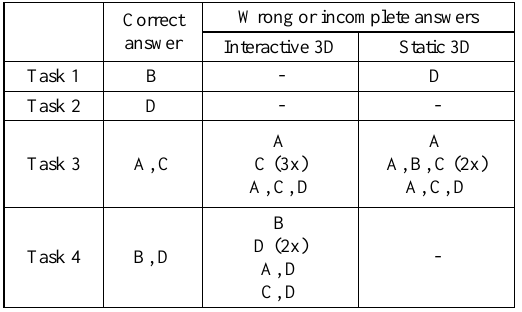
Tab. 1. Summary of correct and wrong answers